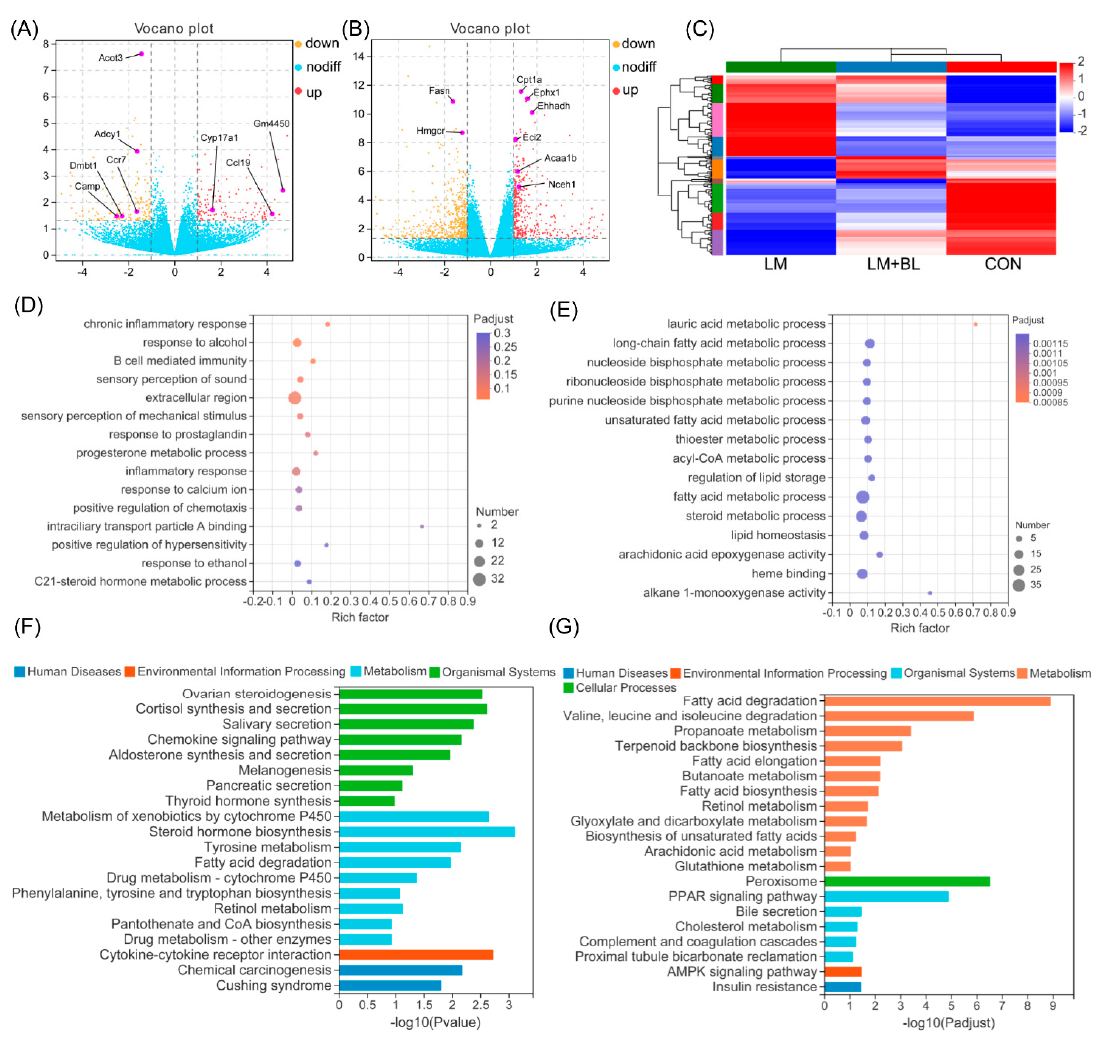
Figure 4. Liver transcriptome. ( A ) Volcano plots of identified genes by comparisons between LM and